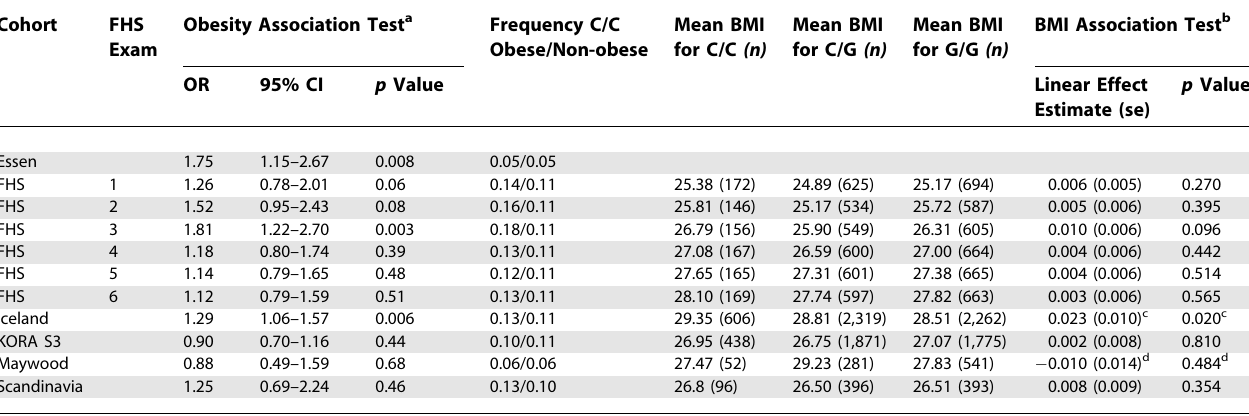
Table 2. Association Studies of rs7566605 C/C Genotype and Obesity (BMI (cid:2) 30) and BMI as a Continuous Trait in Each of the Individual Unrelated